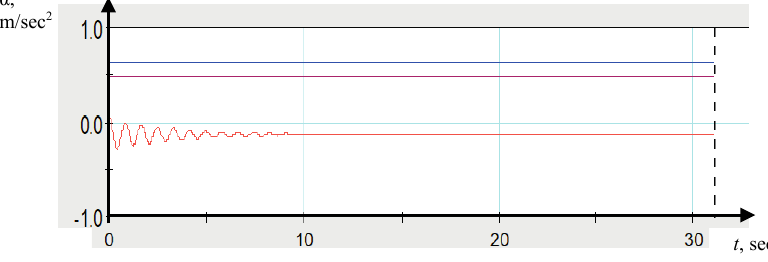
Fig. 9. Acceleration of the sprung mass by computer simulation method with a pendulum; weight per wheel m 1 = 820 kg; t he common mass of pendulum loads ∑ m = 2 m 2 = 20 kg; the spring stiffness C = 2 · 10 4 N/m; the spring damping K = 2 · 10 2 Nm/sec 2